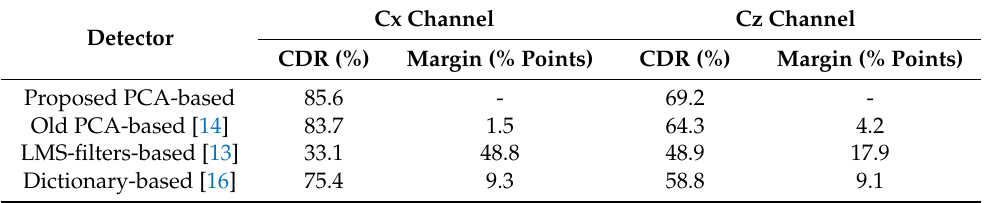
Table 3. CDR for different detectors using the Canon-captured testing images, and statistically significant improvement of the proposed PCA-based